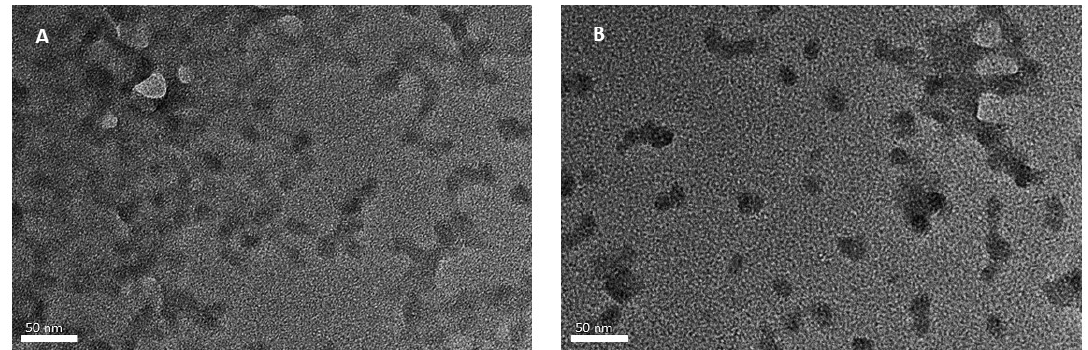
Figure 1. TEM micrograph of ( A ) NPCH and ( B ) NPCH-TQ 1:1.